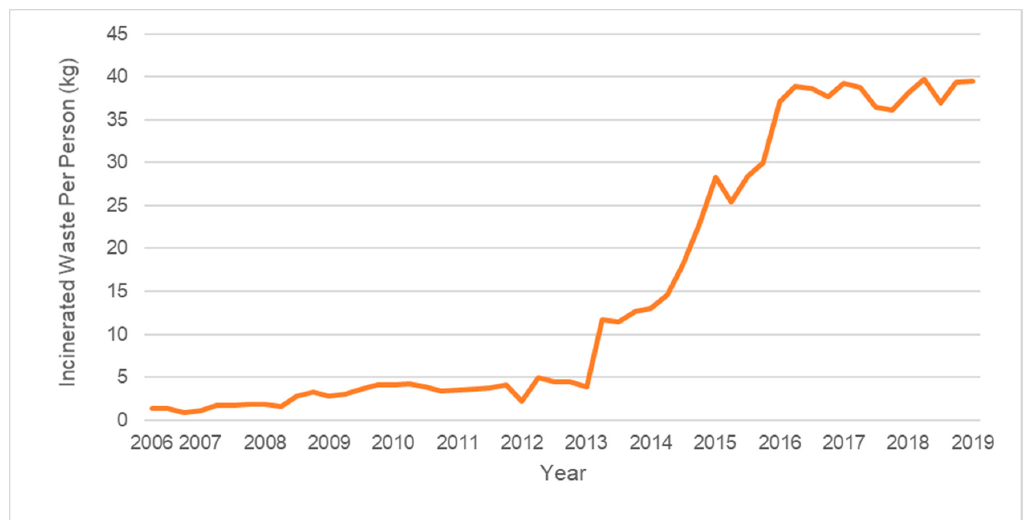
Figure 5. Total incinerated waste per person (kg) per quarter; Welsh average. Source: WasteDataFlow and